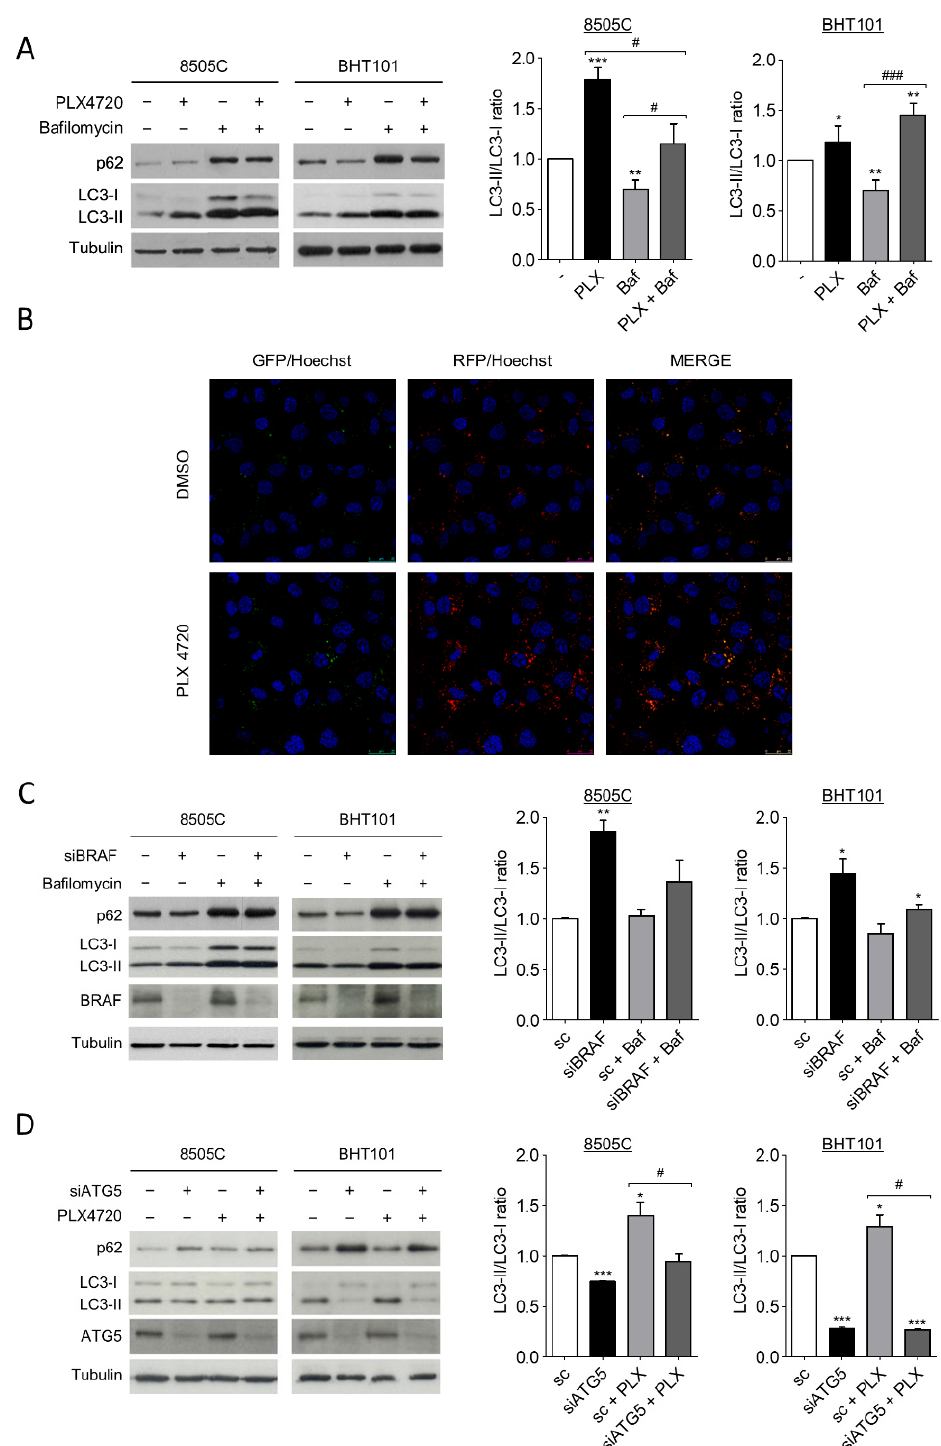
Figure 1. V600E BRAF inhibition induces autophagy in thyroid cancer cells. ( A ) LC3 and p62 protein levels (left blots), and quantitative analysis of LC3-II/LC3-I ratios (right graphs) in cells incubated for 24 h with DMSO (-) or PLX4720 (PLX), in the absence or presence of Bafilomycin A1 (Baf). ( B ) Immunofluorescence in 8505C cells transiently transfected with the mRFP/GFP-LC3 (ptfLC3) plasmid for 48 h, and then treated with DMSO or PLX4720 for 24 h. Autophagosomes are identified by yellow puncta (green and red) and autolysosomes by “red only” puncta. Nuclei were labelled with Hoechst dye. Scale bar is 25µm. ( C ) LC3, p62 and BRAF protein levels (left blots), and quantitative analysis of LC3-II/LC3-I ratios (right graphs) in cells transfected with either an oligo control (sc) or specific siRNA for BRAF (siBRAF) for 72 h, and treated with Bafilomycin A1 for the last 24 h. ( D ) LC3, p62 and ATG5 levels (left blots), and quantitative analysis of LC3-II/LC3-I ratios (right graphs) in cells transfected with an oligo control (sc) or with specific siRNA for ATG5 (siATG5) for 48 h, and then left untreated or treated with PLX4720 for 24 h. For each experiment, membranes were rep- robed with anti- β -Tubulin as a loading control. Graphic bars represent the LC3-II/LC3-I ratio, cal- culated after quantitation of LC3-II and LC3-I bands of the blots, and are presented as fold induction relative to the untreated cells. Blots are from one representative experiment and data shown repre- sent the mean ± SEM of the quantitation of at least three independent experiments performed with similar results. Significant differences compared to the corresponding controls: * 0.01 < p < 0.05, **